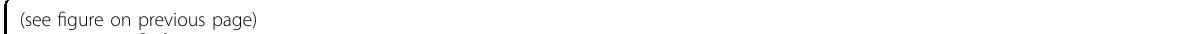
Fig. 2 Moms m3m4 lack induction of an IL-10 mediated immunosuppressive state during pregnancy that correlates with decreased expression of complement in the fetus. A Quantitative real-time PCR for expression of pro-in fl ammatory cytokines in the spleen of Mom m3m4 vs. Mom WT . B Multiplex ELISA quanti fi cation of IL-10 in serum of pregnant females compared to non-parous females (two-tailed t test, ** p < 0.01). C q- RT-PCR based fold change in IL-10 transcript in the spleen of Mom m3m4 vs. Mom WT (one-tailed t test, * p < 0.01). D ELISA quanti fi cation for anti- phospholipid antibodies in serum of mothers (one-tailed t test, ** p < 0.01). E IHC for Fc γ R expression in E14.5 placental decidua. Scale bars = 100 µm. F ELISA for GDF-15 in fetal livers at E17.5. G Heat map of complement pathway gene expression showing unsupervised clustering of Fetuses m3m4 based on their maternal genotype (Mom m3m4 : brown vs. Mom WT : orange). H (Top panel) Nanostring analysis showing average transcript counts/ mother (normalized to a housekeeping gene panel) for complement genes in fetal livers (each data point depicts the average of two fetuses/mother, n = 5 mothers/group). (Lower panel) correlation of complement gene expression in the fetal liver with maternal serum IL-10 levels. Blue dots: Mom WT , blue dots with a red outline: Mom m3m4